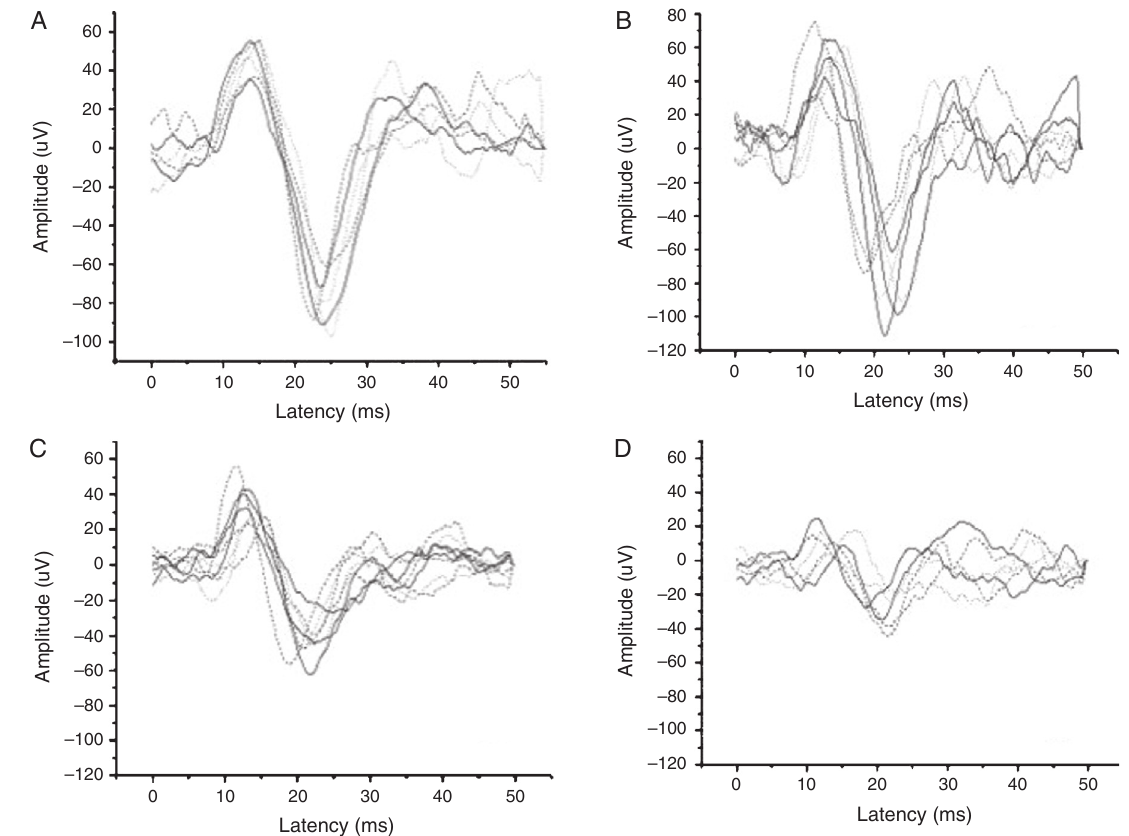
Records of vestibular evoked myogenic potential wave tracings by tone-burst stimuli frequency. To obtain a recording of VEMP in the sternocleidomastoid PASW Statistics data editor software (version 17.0) was muscle, the patient remained seated, with maximum lateral used for data analysis. The Shapiro---Wilk test was rotation of the head to the side contralateral to the stimu- lus, and maintained a tonic contraction of the muscle around 60---80 (cid:2) V, which was monitored by means of surface elec- tromyography. The stimuli presented through ER-3A insert earphones was introduced in the right afferent and, subse- quently, was repeated in the left afferent. The responses were replicated, that is, recorded three times on the right side and three times on the left side. Those tests presenting vagueness of the recording of the waves in the VEMP tracing, due to the presence of noise and artifacts, were excluded. On examination of VEMP, 100 tone-burst stimuli were averaged at frequencies of 250, 500, 1000, and 2000 Hz, with a duration of 10 ms (uphill: 4 ms, plateau: 2 ms, down- hill: 4 ms), a rate of 5 Hz, a sound intensity level of 95 dB nHL, and with the use of a band-pass filter of 5---2200 Hz.